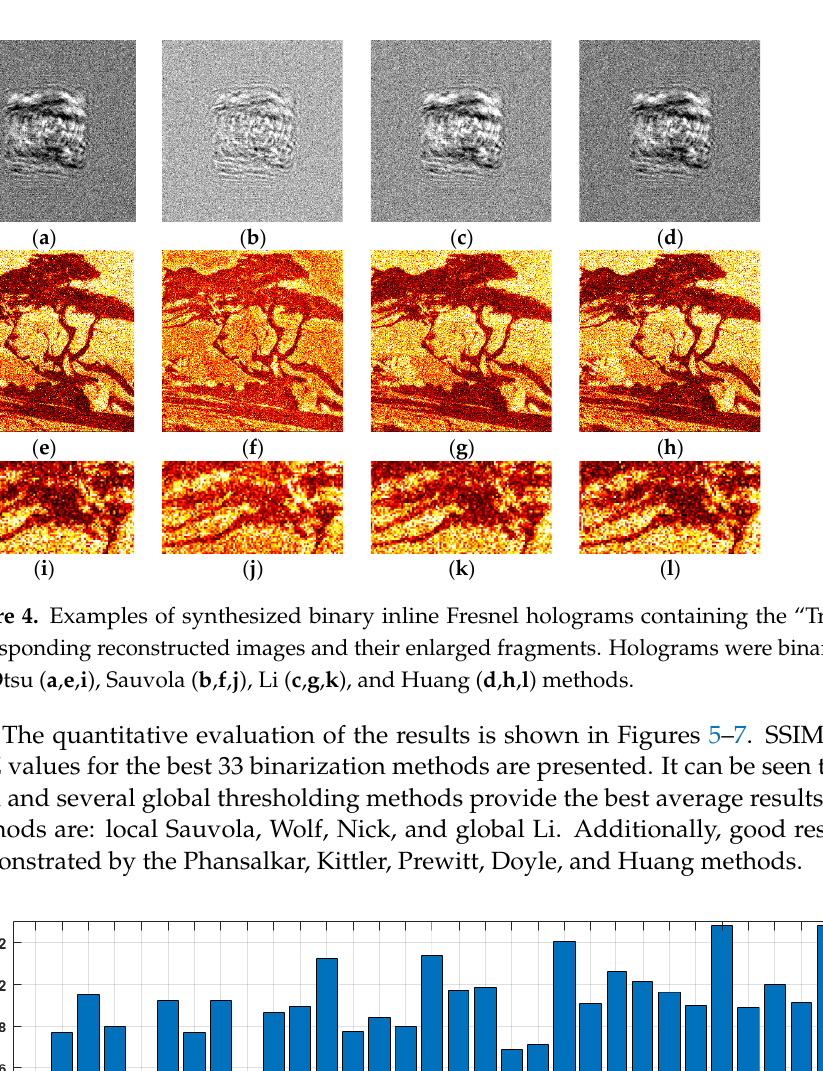
Figure 3. Examples of synthesized binary inline Fresnel holograms containing the “House” image, corresponding reconstructed images and their enlarged fragments. Holograms were binarized us- ing the Otsu ( a , e , i ), Sauvola ( b , f , j ), Li ( c , g , k ), and Huang ( d , h , l ) methods.